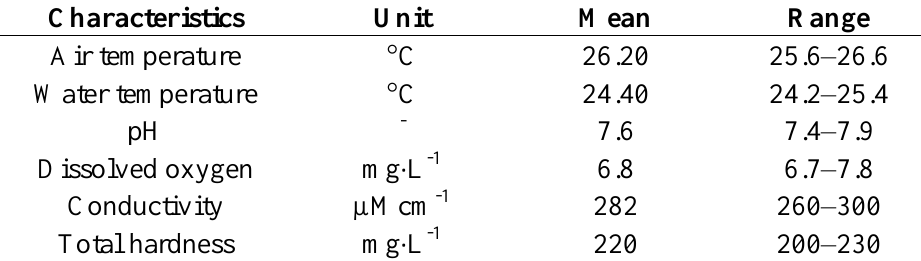
Table 1. Physico-chemical properties of the test